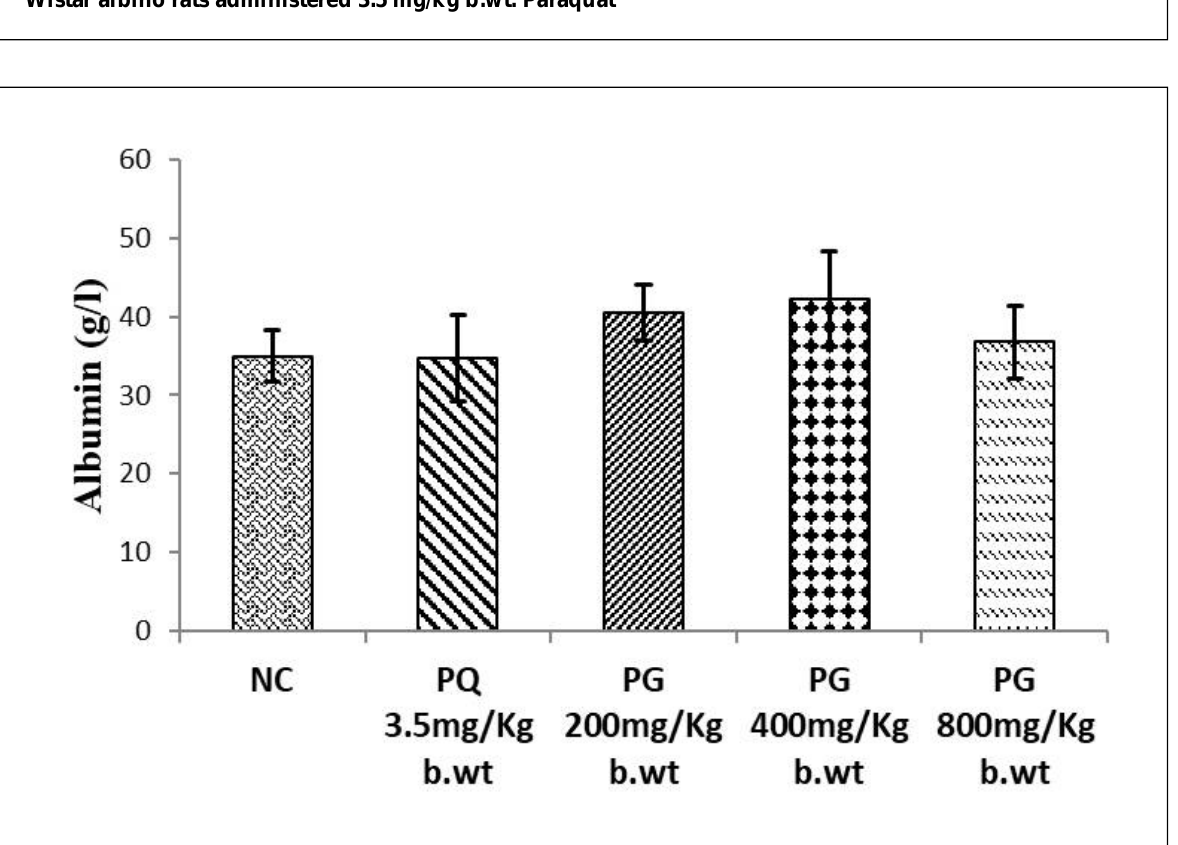
Figure 5: Effect of Psidium guajava leaf extract administration on serum albumin concentration of male Wistar albino rats administered 3.5 mg/kg b.wt.